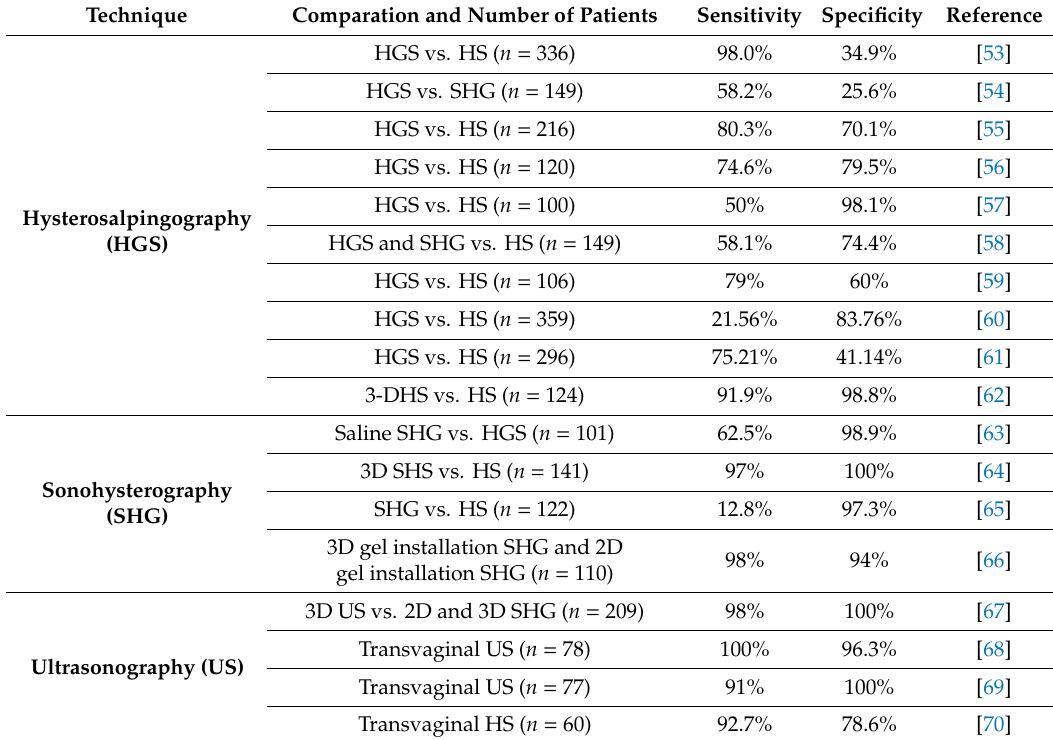
Table 3. Sensitivity and specificity of each technique used for intrauterine pathology